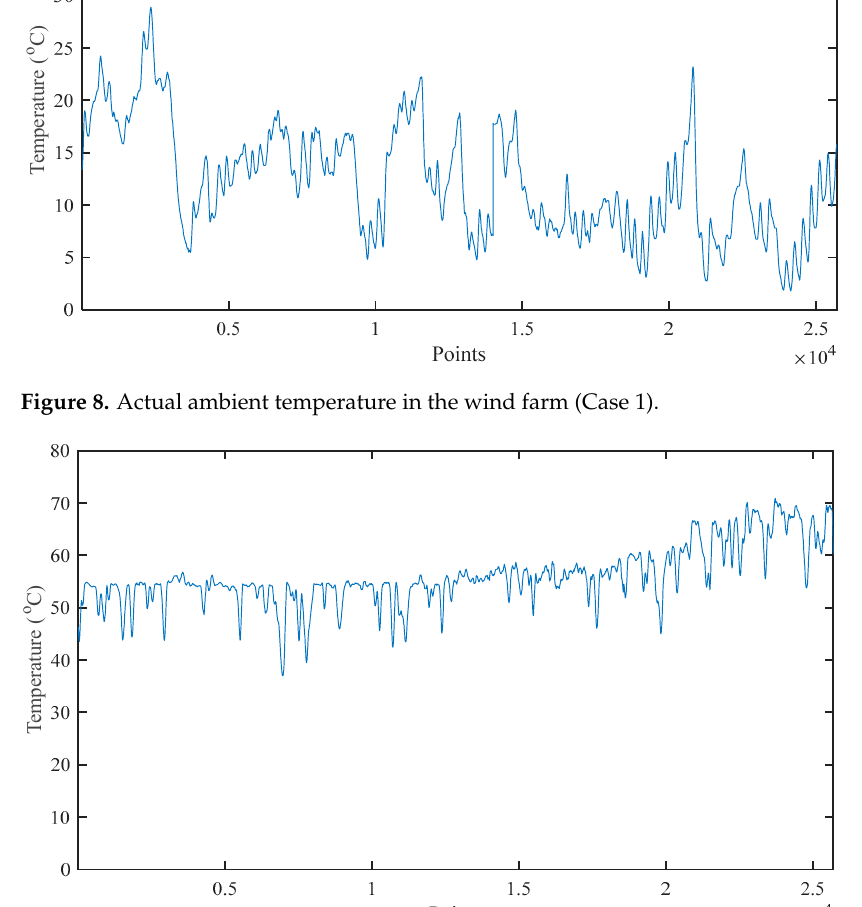
Figure 9. Actual temperature of the gearbox oil obtained from the SCADA data (Case 1). Figure 10 illustrates the condition monitoring model output of wind turbine gearbox oil temperature from a BP model and a GMDH model. Figure 11 shows the residual gearbox oil temperature signals from the BP model and GMDH model. The residual signals were obtained from the difference between a condition monitoring model output and the actual wind turbine gearbox oil temperature from the SCADA data. It showed that the residual signal between the actual gearbox oil temperature of the wind turbine and condition monitoring model output stayed at a low level with fluctuations since the beginning and exhibited an increasing trend at the sampling point 18,600 for BP model and at sampling point 18,590 for GMDH model; thereafter, successive residual errors held at a high level, which indicated a potential fault occurred in the wind turbine gearbox. In order to verify the correctness of the proposed condition monitoring model, the alarm logs of the wind turbine SCADA system had been investigated to check this abnormal behavior which occurred in the wind turbine gearbox. The results showed that both the BP model and GMDH condition monitoring model outputs were consistent with the alarm logs of the wind turbine SCADA system. The fault detection results based on the GMDH condition monitoring model provided the abnormal indication slightly earlier than that of BP based model.